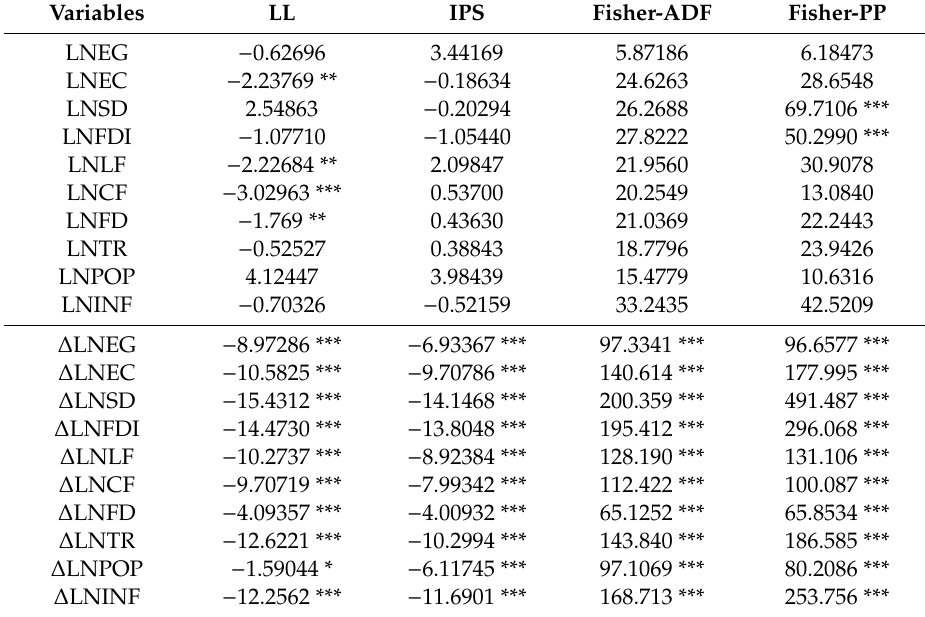
Table 3. Panel Unit Root